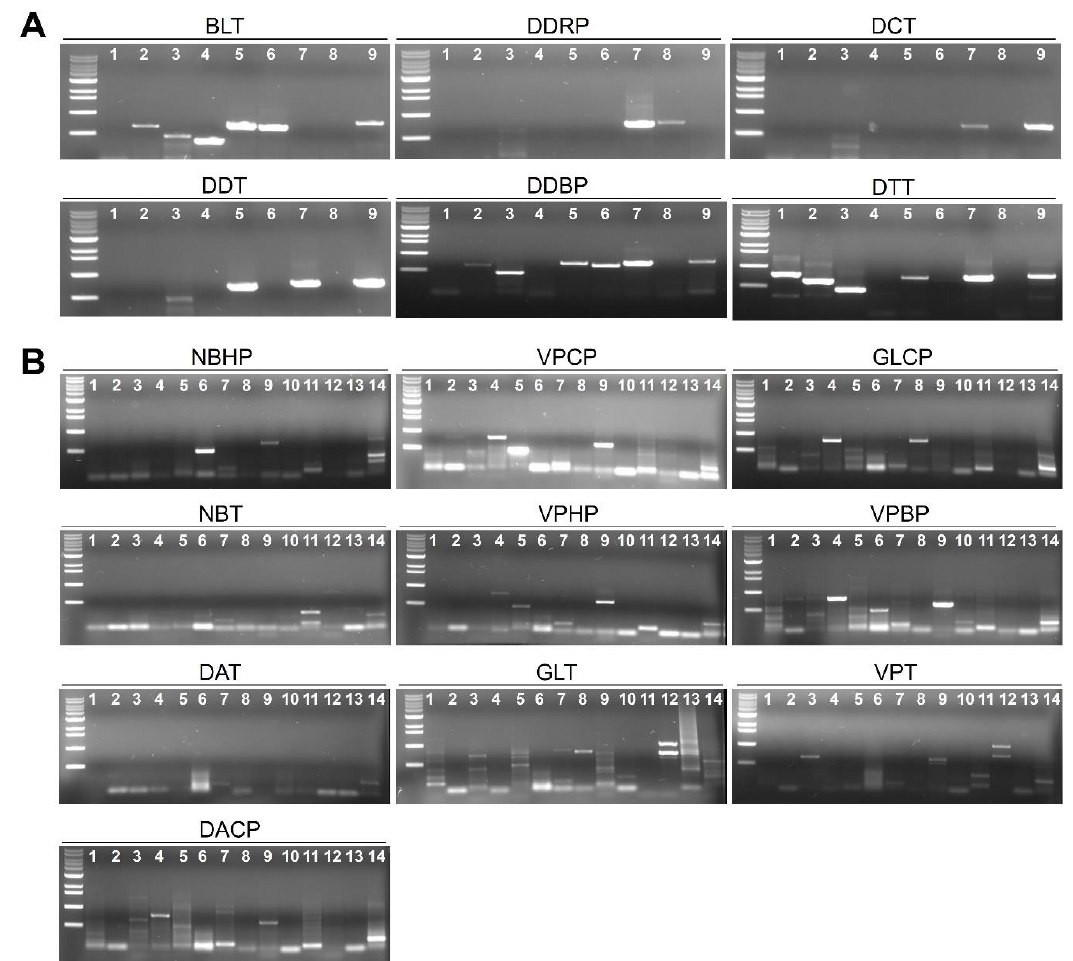
Figure 7. Confirmation of identified viruses and viroids by RT-PCR. RT-PCR results of viruses and viroids identified from the Southern ( A ) and Northern area ( B ) of Vietnam. Each sample on the gel was indicated by different number as follows (for panel A; 1-PVY, 2-CMV, 3-ToMV, 4-AVYCNV, 5-TYLCKaV, 6-CaCV, 7-TNRV, 8-PCV2, 9-STV, for panel B; 1-ChiVMV, 2-PVY, 3-CMV, 4-PCV2, 5-PMMoV, 6-TMGMV, 7-STV, 8-TNRV, 9-PeVYV, 10-ToLCVV, 11-TYLCVNV, 12-LAYVV, 13-CLVd, 14-PCFVd).